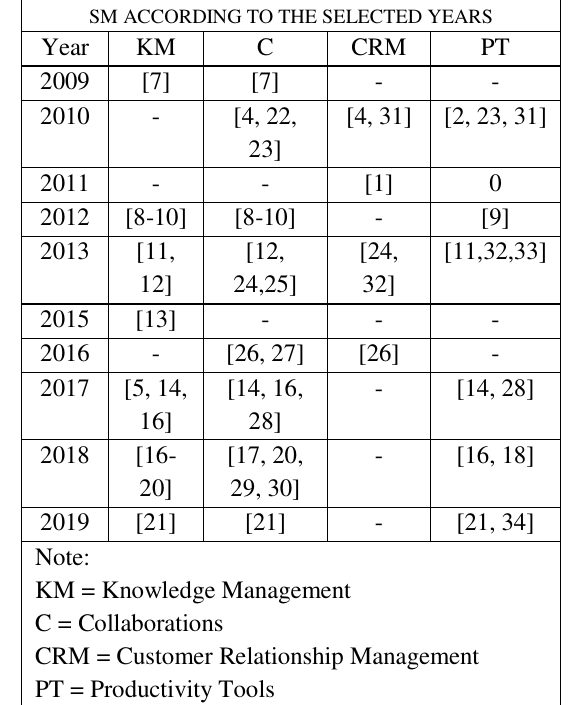
TABLE 3: REFERENCES FOR PURPOSES OF USING